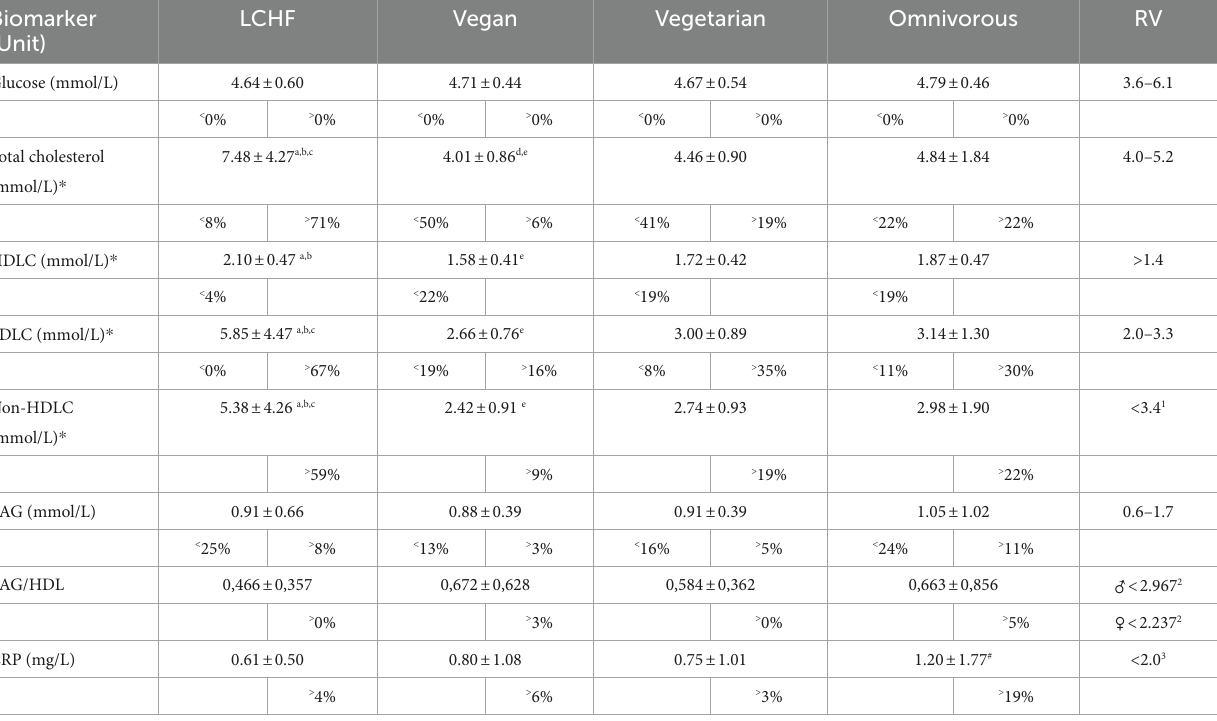
TABLE 5 Serum biomarkers. Biomarker